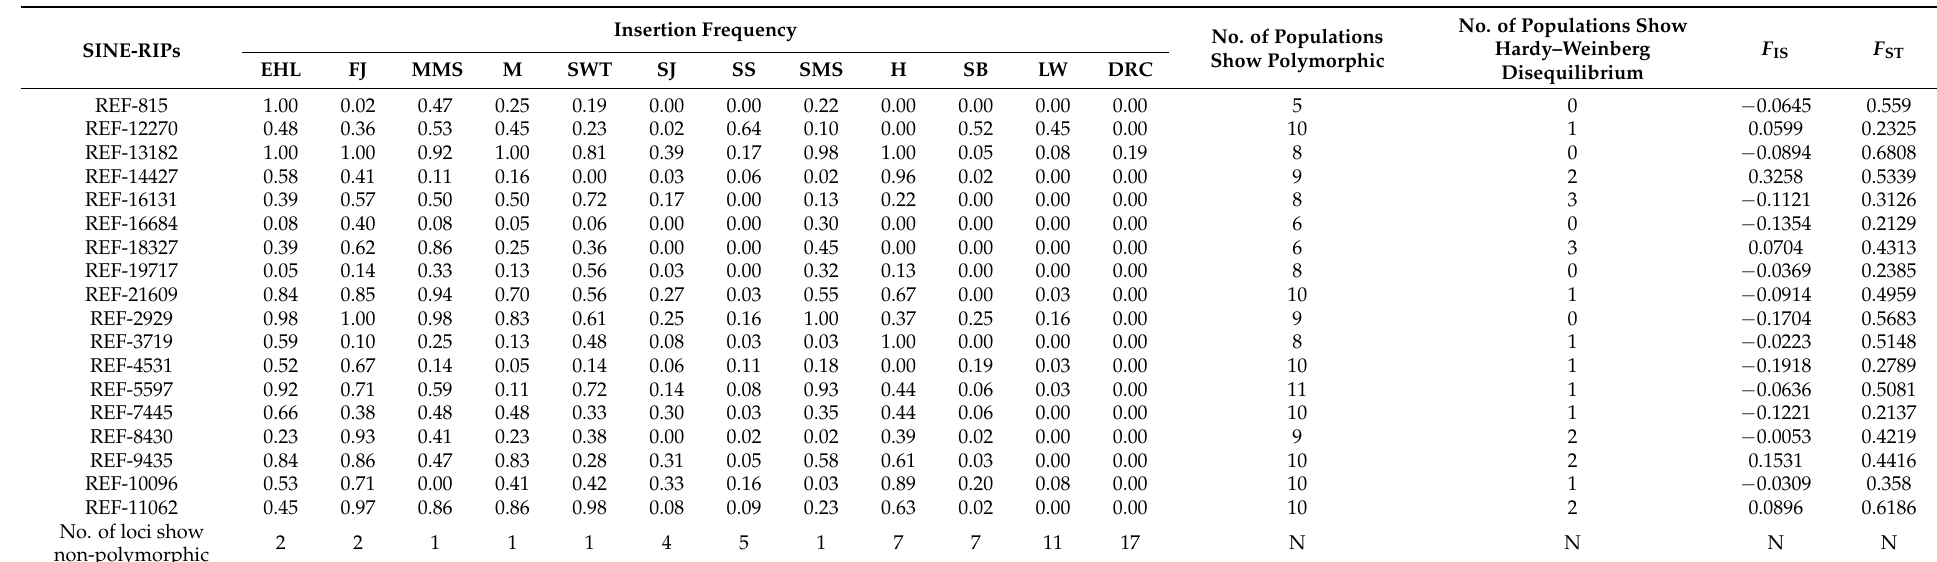
Table 1. Polymorphism of SINE RIPs in 12 pig